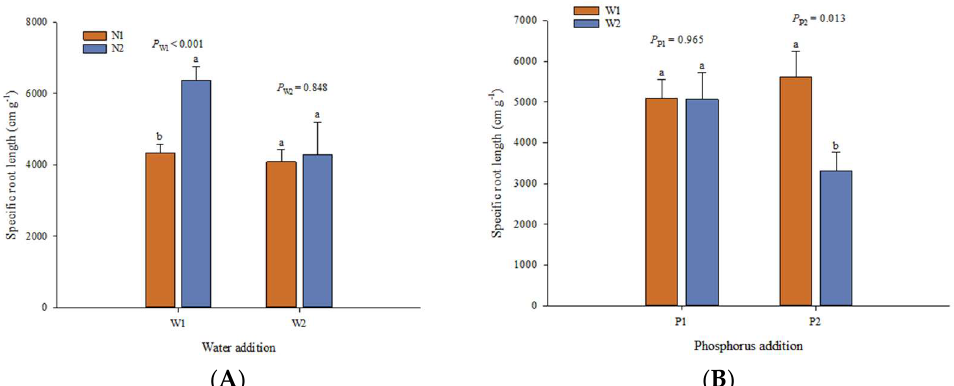
Figure 6. Effects of water addition × nitrogen addition ( A ) and water addition × phosphorus addi-